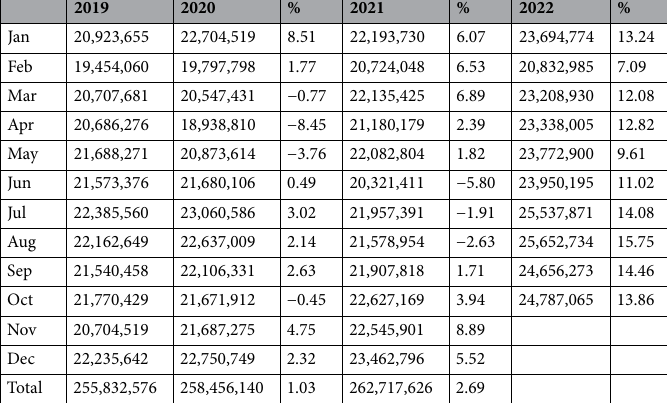
Table 4. Monthly operating income of 7-Eleven stores from 2019 to 2022.